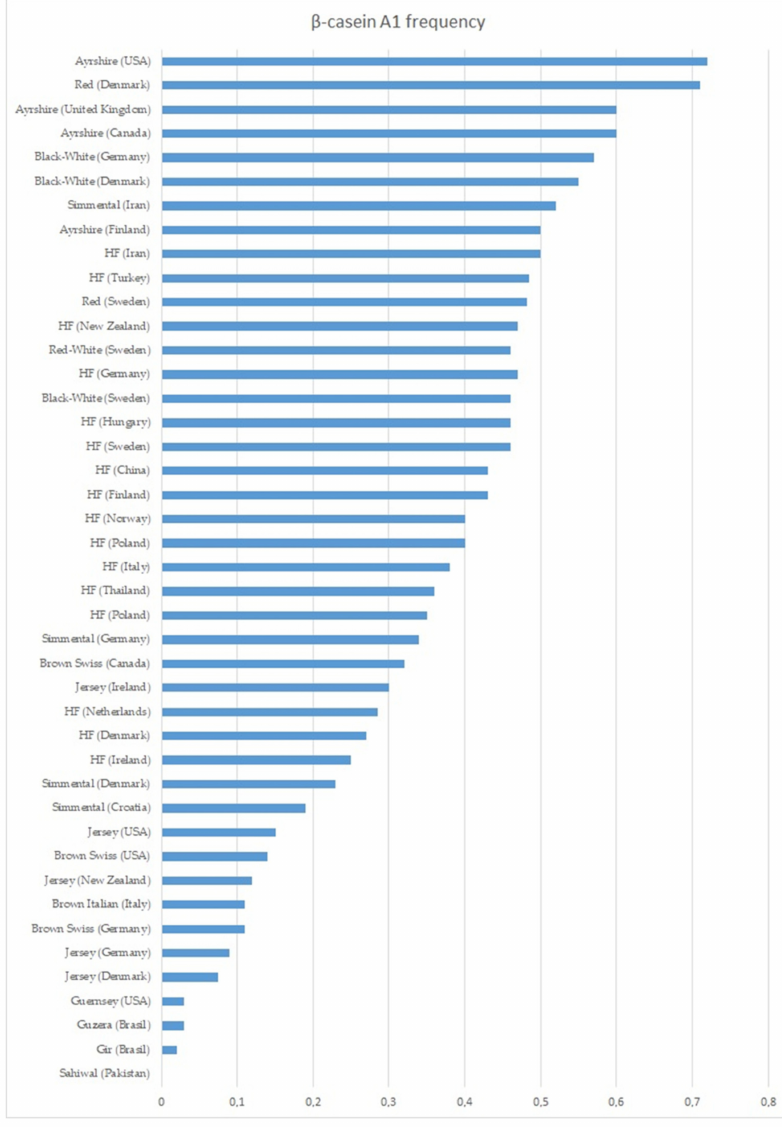
Figure 2. Frequency of the A1 β -casein gene variant in various breeds and